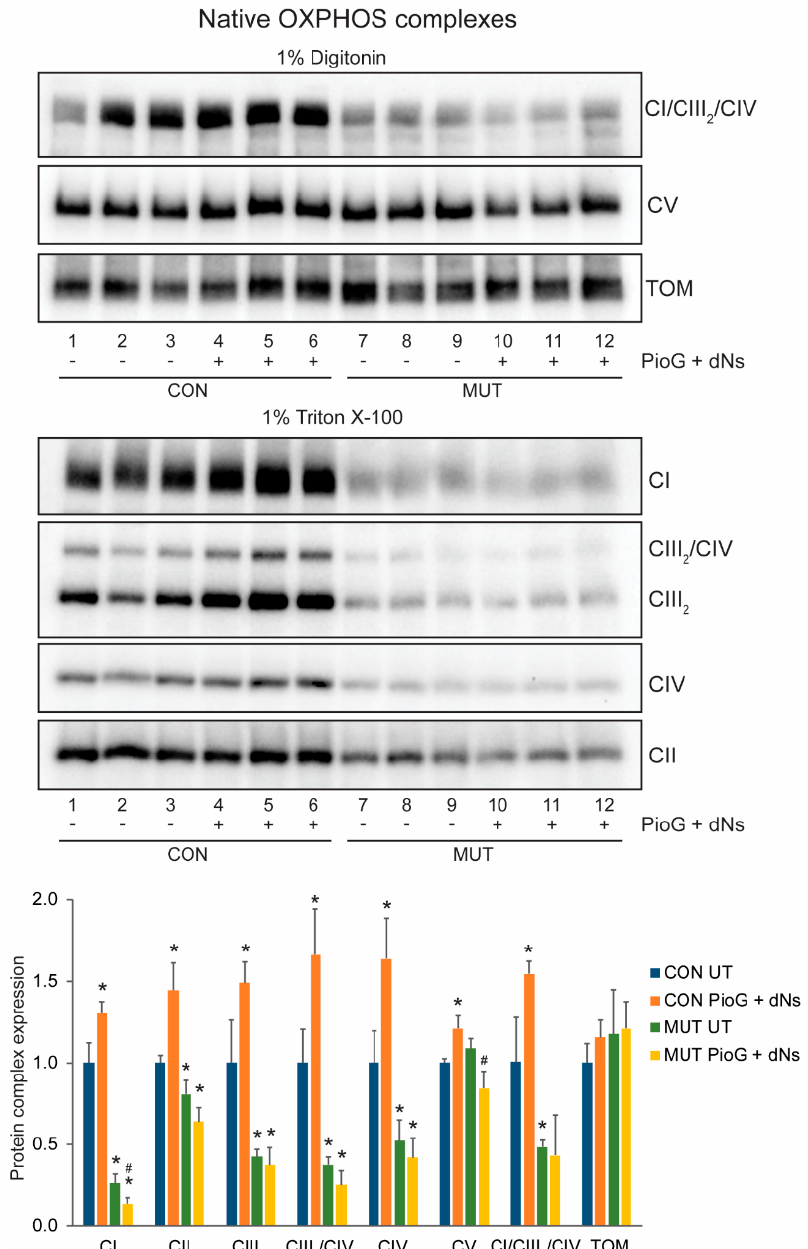
Figure 4. Effect of seven days of PioG + dNs combination treatment on mature OXPHOS complex steady-state levels in control (CON) cybrids and m.3243A>G (MUT) cybrids. Levels of complex I (CI), complex II (CII), the complex III dimer (CIII 2 ), complex IV (CIV), the CIII 2 /CIV supercomplex, and the CI/CIII 2 /CIV supercomplex were lower in untreated MUT cybrids compared to CON cybrids. PioG + dNs treatment resulted in the increase in all OXPHOS complex and supercomplex levels in CON cybrids, but did not increase any complexes in MUT cybrids. UT = untreated. Values shown are mean ± s.d. * p < 0.05 relative to untreated CON values; # p < 0.05 relative to untreated MUT values (Student’s t -tests).